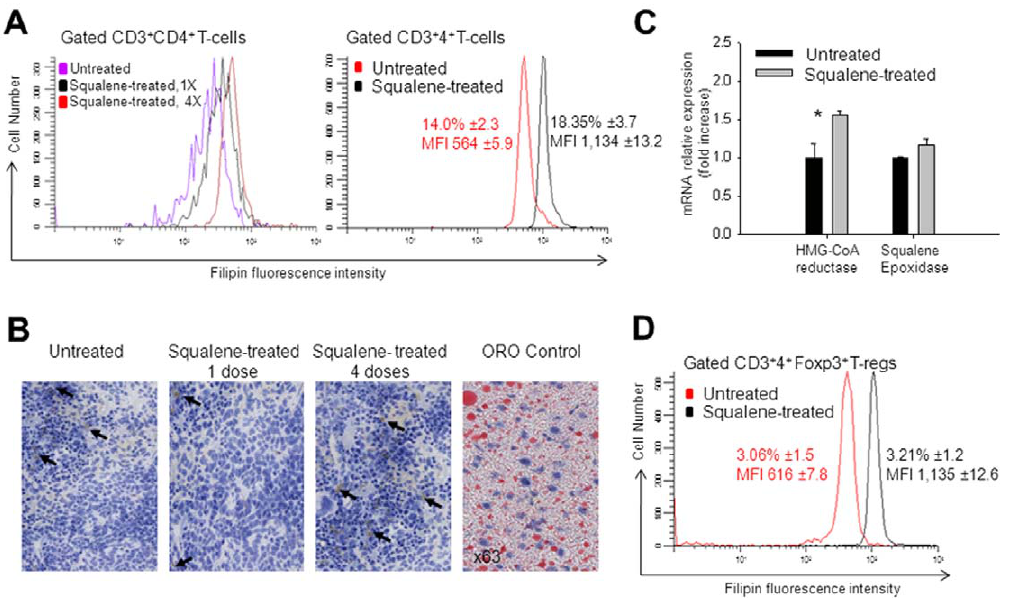
Figure 1. Squalene administration leads to accumulation of membrane cholesterol in resting CD4 T-cells. ( A ) F1 hybrid mice (n=5/ group) were injected i.p. or not (purple line) with a single dose (black line) or 4 doses of squalene (red line) within a week interval (180 m g/dose/ mouse). Seven days after the last injection, negatively-sorted splenic CD4 cells from individual mice were co-stained with CD3-PE, CD4-FITC and Filipin III. Shown is the amount of cholesterol in plasma cell membrane of gated CD3 + CD4 + splenic cells as measured by MFI of Filipin III in FACS at single-cell level in one representative mouse from each group ( left panel ). Right panel , F1 hybrid mice (n=7/group) were injected i.p. (black line) or not (red line) with a single dose of squalene (180 m g/mouse) and 7 days later negatively-sorted splenic CD4 cells from individual mice were co-stained with CD3-PE, CD4-FITC, and Filipin III. Shown is the percentage of gated CD4 + T-cells 6 standard deviation (SD) and MFI values of Filipin III 6 SD before and after squalene injection as collected among 700 cell events in gated population of CD3 + 4 + T-cells for one of three representative experiments. ( B ) Cholesterol accumulation in the spleen was identified by Oil Red O (ORO) staining of frozen spleen sections, counter-stained with hematoxylin from untreated or squalene treated mice (180 m g/mouse) given one or four doses, and analyzed 7 days post-injection (n=3/group). Left panel, spleen section from untreated mouse. Middle panels, spleen section from squalene treated mice. Right panel, positive control for ORO lipid droplet staining in adipocytes. Shown is one representative ORO stained section in each group. Dark arrows indicate ORO stain. ( C ) Quantitative real- time RT-PCR of HMG-CoA reductase mRNA and Squalene epoxidase mRNA extracted from negatively-sorted CD4 splenocytes isolated from individual F1 hybrid mice (n=5/group) that were treated (light bars) or not treated (dark bars) with a single dose of squalene (180 m g/mouse) and analyzed 7 days post-injection. Y axis indicates the mean fold increase in mRNA expression level relative to the endogenous 18S rRNA expression level (control 6 standard deviation (SD). Shown are two combined separate experiments (* p value , 0.05). ( D ) FACS measurements of CD3 + 4 + Foxp3 + T-reg cells from negatively-sorted CD4 + splenic cells of the same F1 mouse groups analyzed in panel A that were co-stained with CD3-PE and Filipin III. Shown is the percentage of gated CD4 + Foxp3 + T-reg cells 6 SD and MFI values of Filipin III 6 SD collected among 500 cell events in the gated population of GFP + - Foxp3 /GFP + cells from one mouse in each group from two representative experiments.